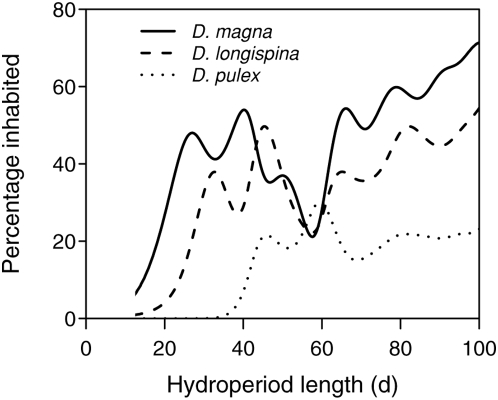
Predicted occurrence of Daphnia.Estimated percentage of pools that contained the specific Daphnia species at least once over the 25 years (independent of occupation length) in relation to the predicted mean annual hydroperiod length (days, considering May to September). Percentages are calculated from kernel density estimates of inhabited versus all pools.